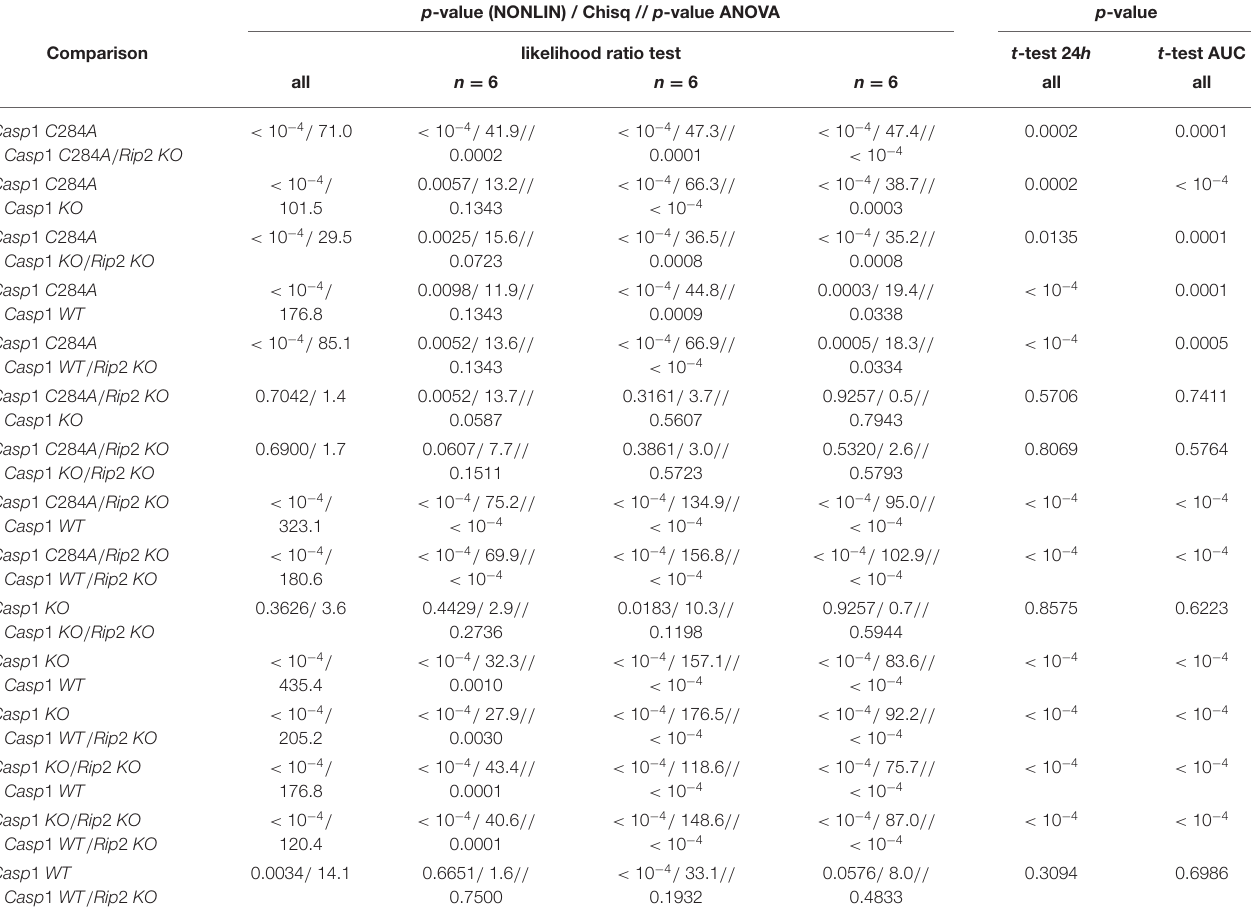
TABLE 1 | Statistical analysis of pairwise comparisons of temperature-time courses. p -value (NONLIN) / Chisq // p -value ANOVA p -value Comparison likelihood ratio test t -test 24